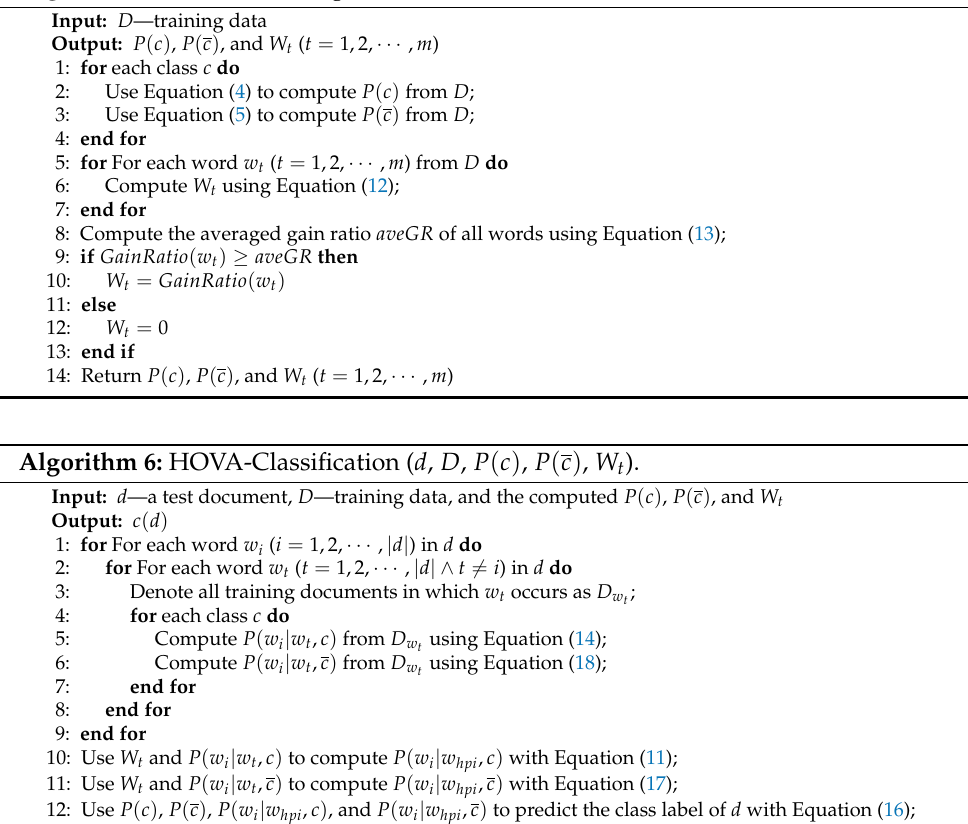
Algorithm 5: HOVA-Training ( D ).